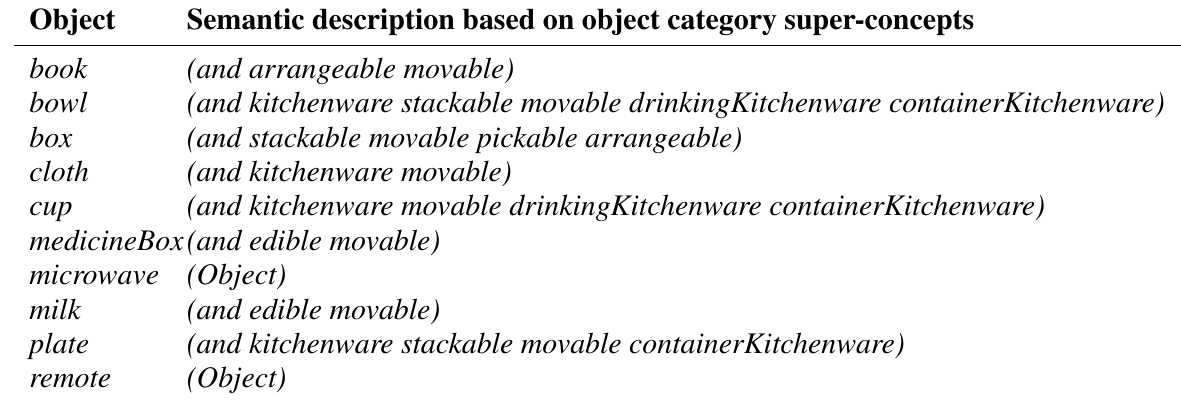
Table 10. Objects’ semantic descriptions based on usage-driven object categories.